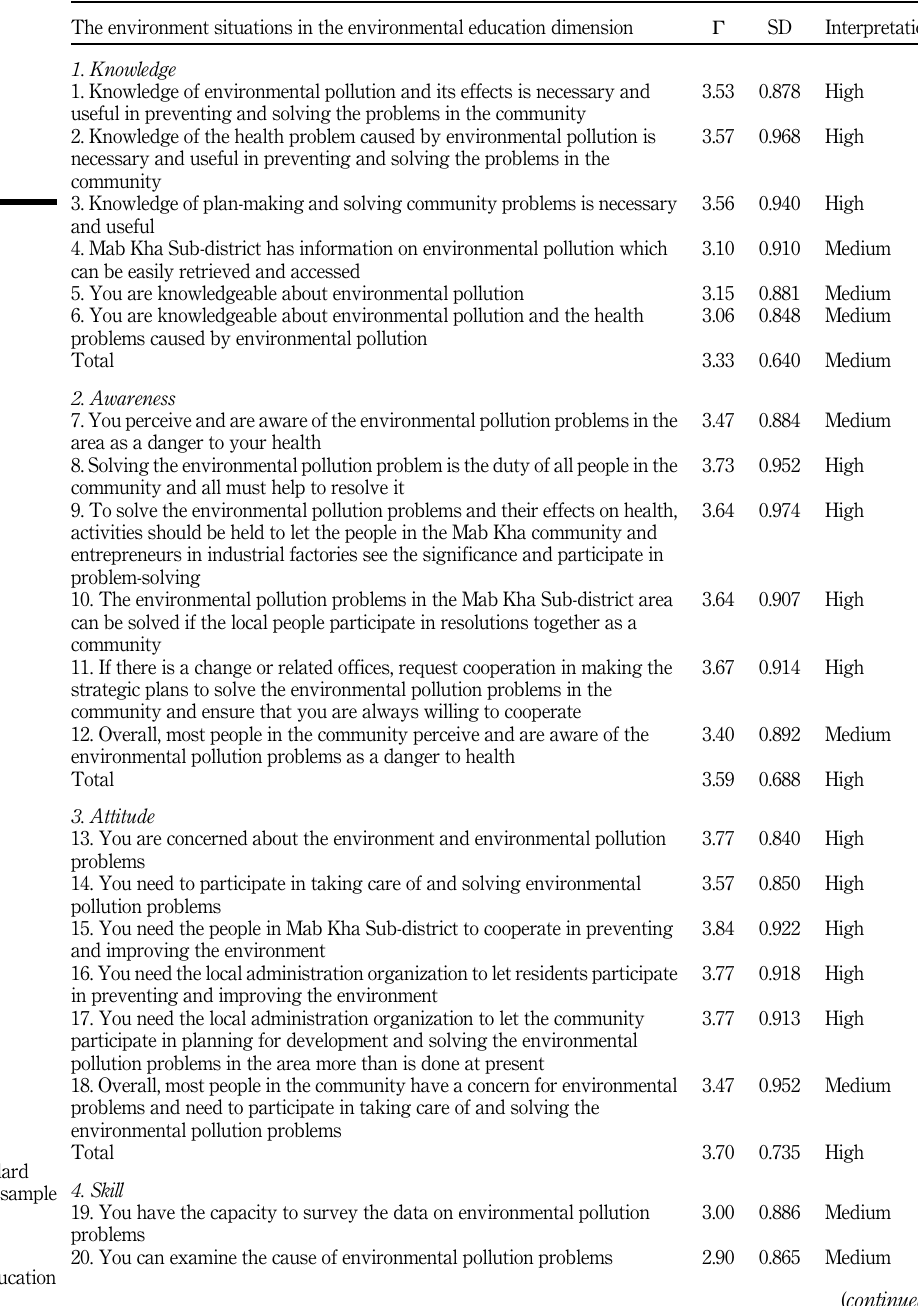
deviation of the sample based on the environmental situation in